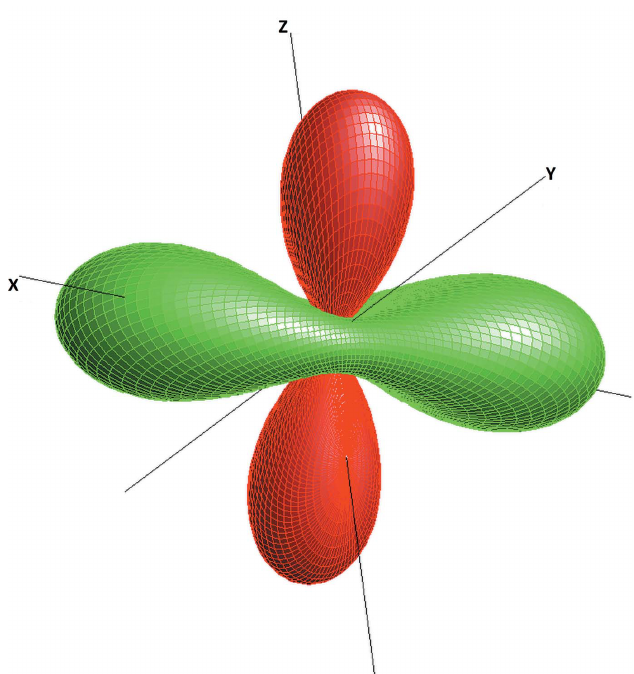
Figure 6 Representation surface of the compositional strain tensor with respect to the underlying Cartesian coordinate system. Green and red parts of the surface indicate positive and negative values, sponding angles with a , b and c , respectively: e 33.3 (cid:2) ); e : (72.5 (cid:2) ; 44.4 (cid:2) ; 122.5 (cid:2) ); e 2